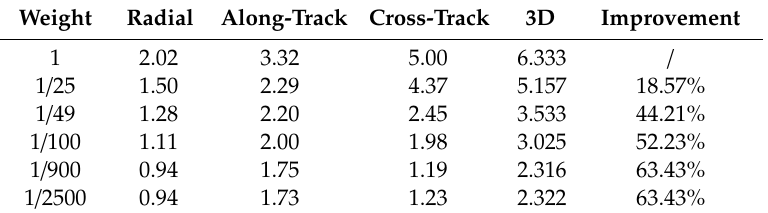
Table 5. The precision of Luojia-1A precise orbit results with di ff erent GEO weighted strategies (Unit: